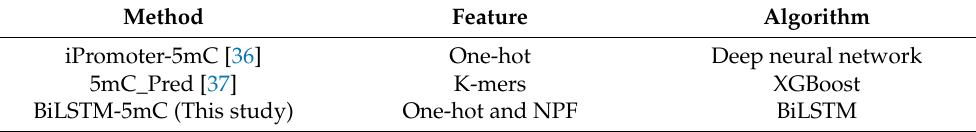
Table 1. Summary of existing tools for 5mC sites prediction in genome-wide DNA promoters.